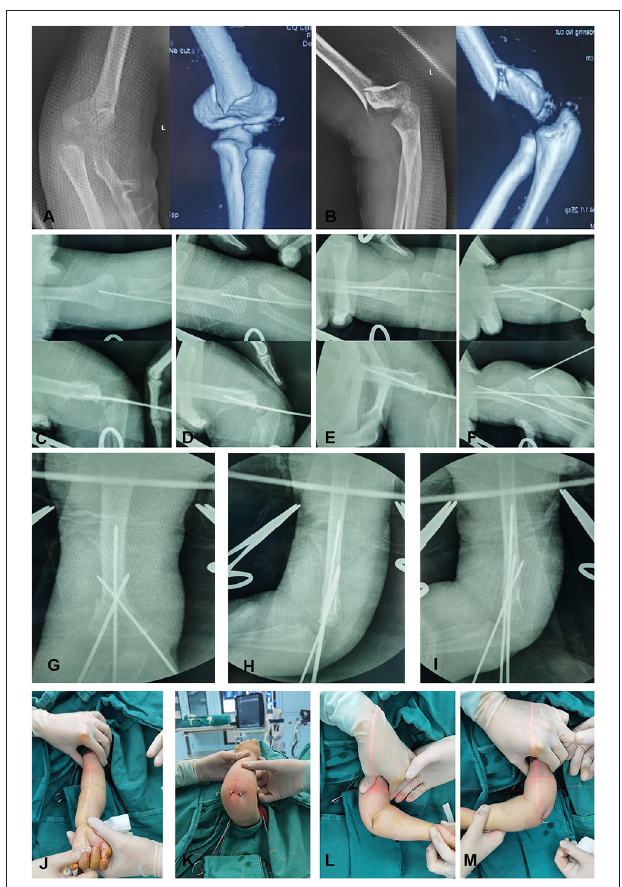
FIGURE 1 | A 2-year-old girl with displaced MDJ fracture of her left elbow. (A) The anteroposterior (AP) radiograph and coronal 3D-CT image of the MDJ fracture; (B) the lateral radiograph and sagittal 3D-CT image of the fracture; (C) the AP and lateral radiographs when inserting a pin into the distal fracture end; (D) the AP and lateral radiographs where the intramedullary pin crosses the fracture line; (E) the AP and lateral radiographs when driving the pin through the fracture line and into the intramedullary canal; (F) the AP radiographs of cross-pin placement; the AP (G) , lateral (H) , and oblique (I) radiographs after cross-pin configuration; (J–M) the post-operative appearance of the elbow after this novel, minimally invasive